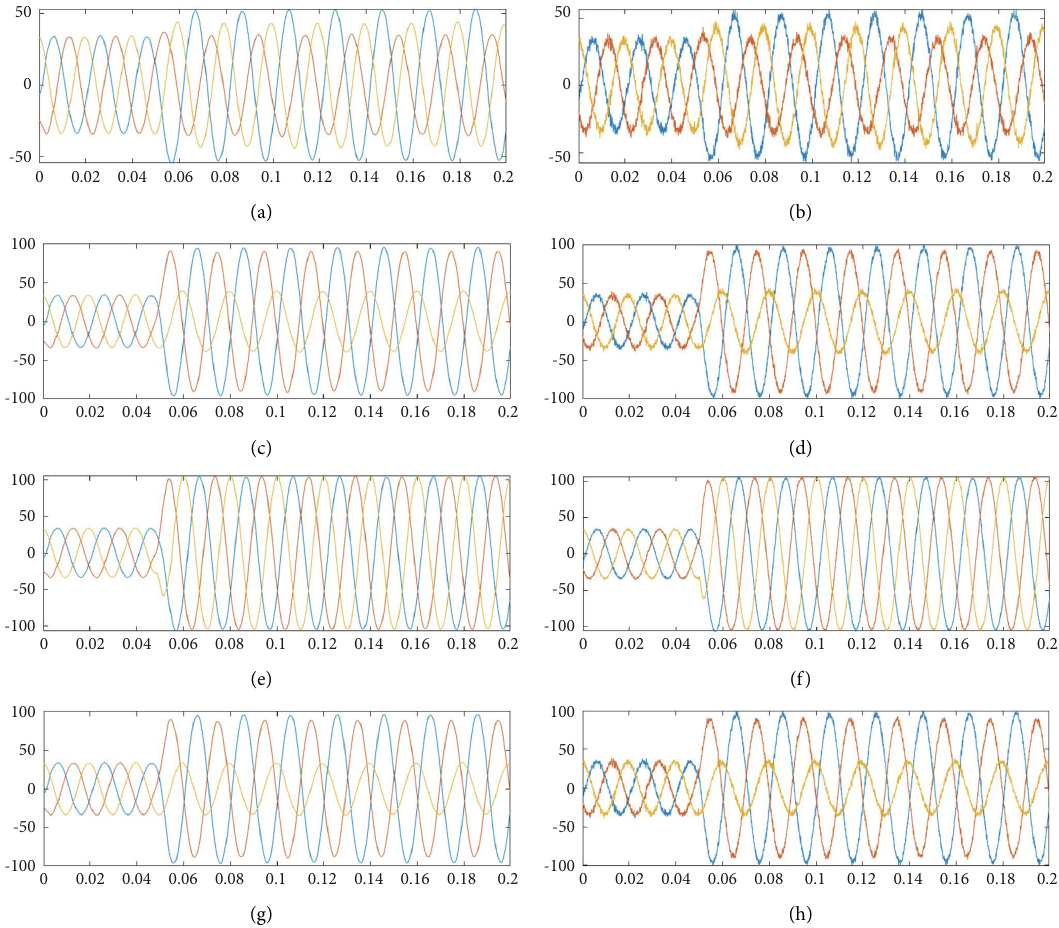
Figure 4: Waveforms of various short-circuit fault current. (a) A_G fault. (b) A_G fault with noise (SNR � 22.2183). (c) AB_G fault. (d) AB_G fault with noise (SNR � 26.5354). (e) ABC_G fault. (f) ABC_G fault with noise (SNR � 32.6782), (g) A_B fault. (h) A_B fault with noise (SNR � 26.4324).